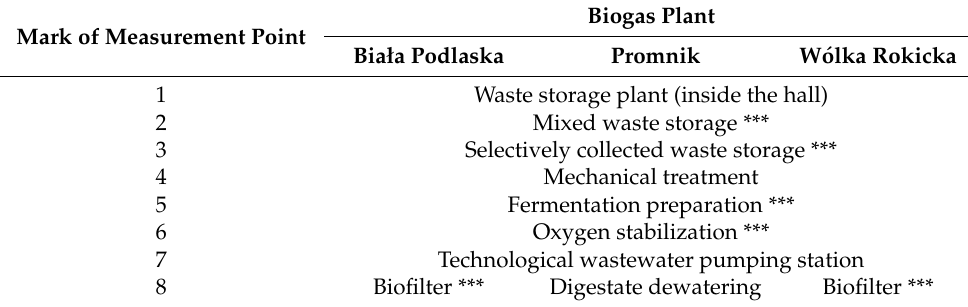
Table 2. Measurement points in particular waste treatment plants.